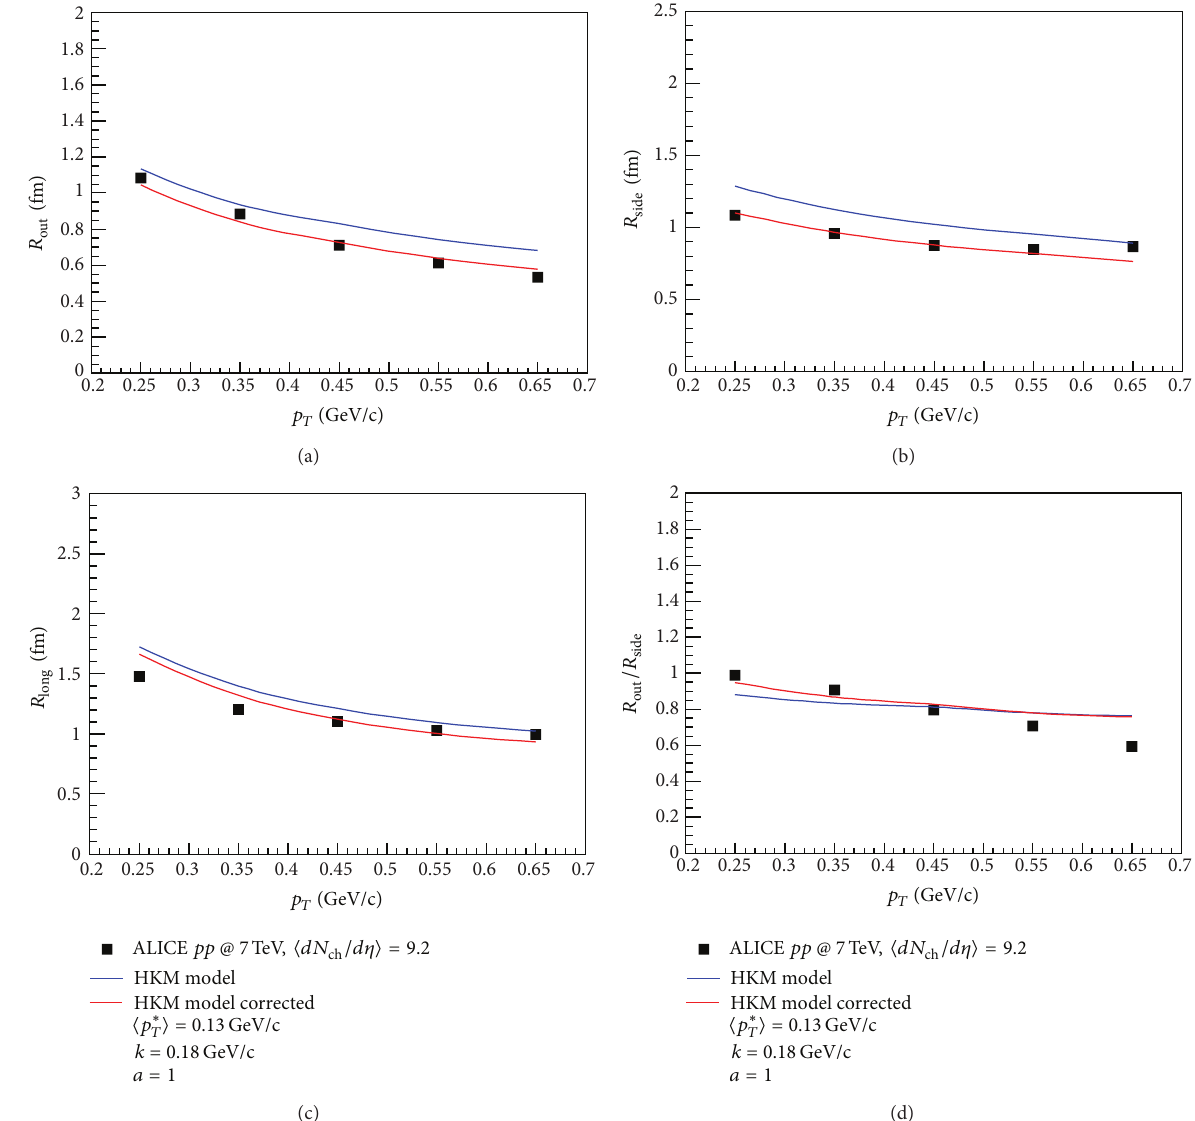
Figure 5: Interferometry radii dependency on 𝑝 𝑇 , ⟨𝑑𝑁